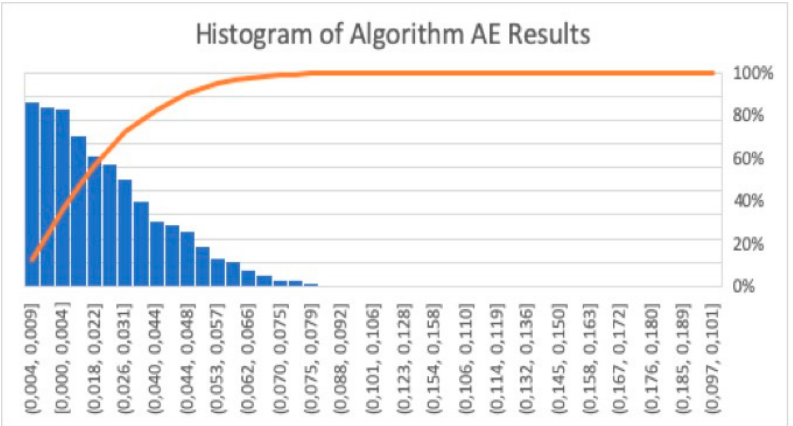
Figure 7. ANN results precision (X axis) after training, for the period before the OH 1.